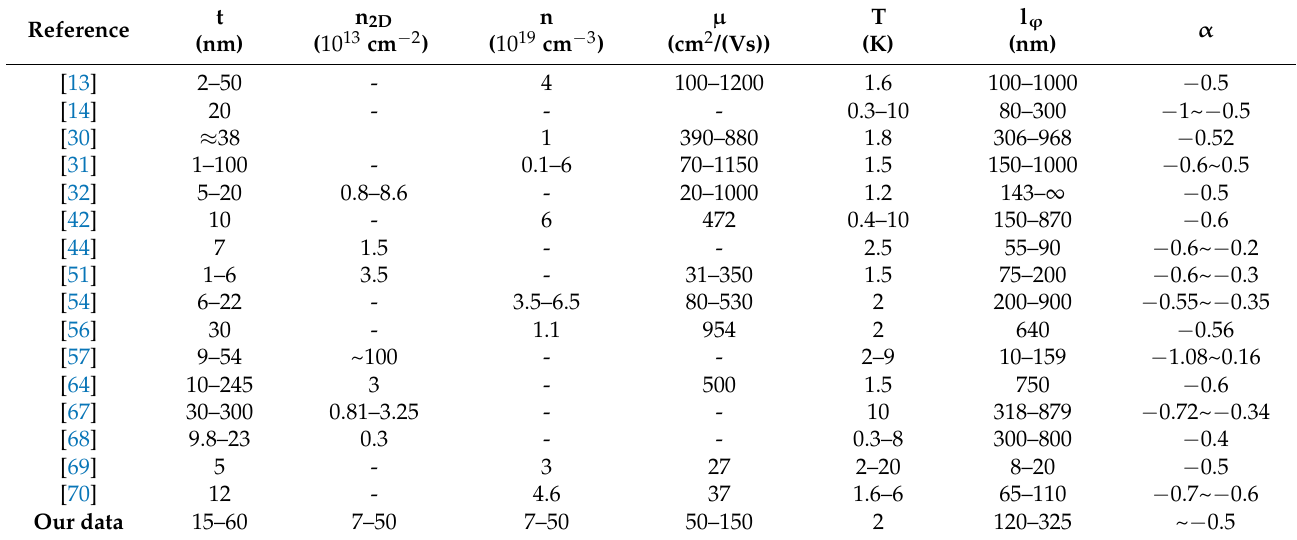
Table 1. Transport parameters of Bi 2 Se 3 thin films reported in the literature.